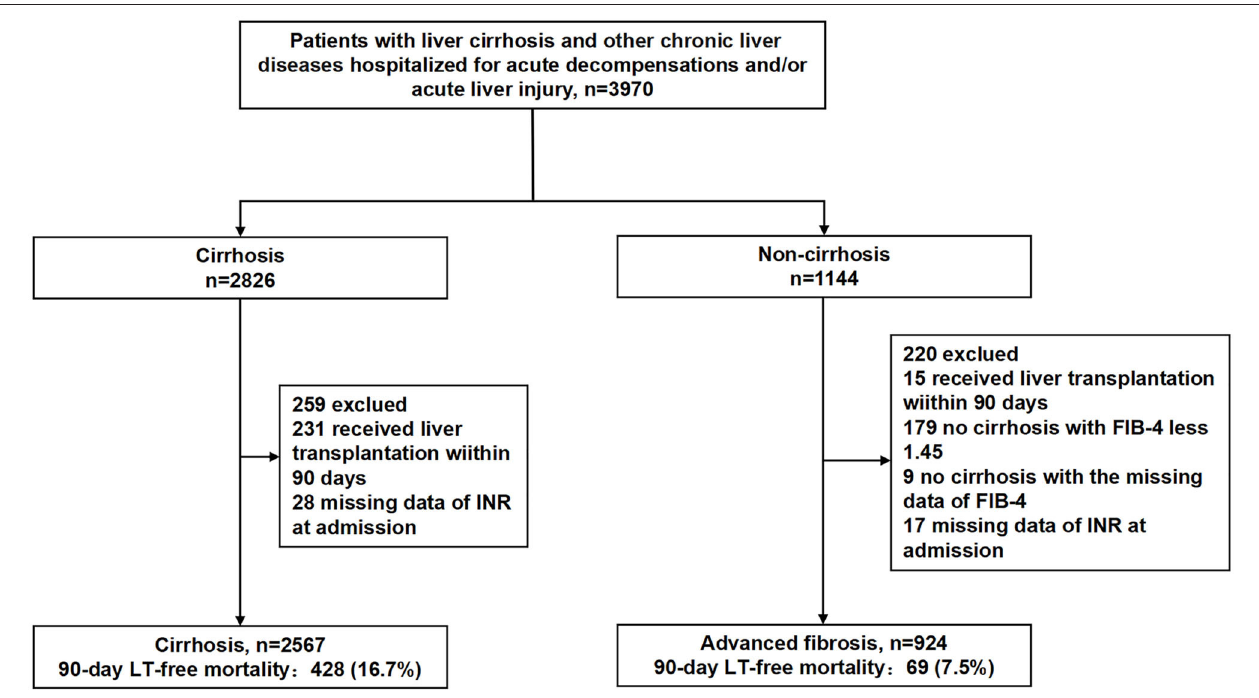
FIGURE 1 | Study participants. FIB-4, fibrosis-4 index; INR, international normalized ratio; LT, liver transplantation.